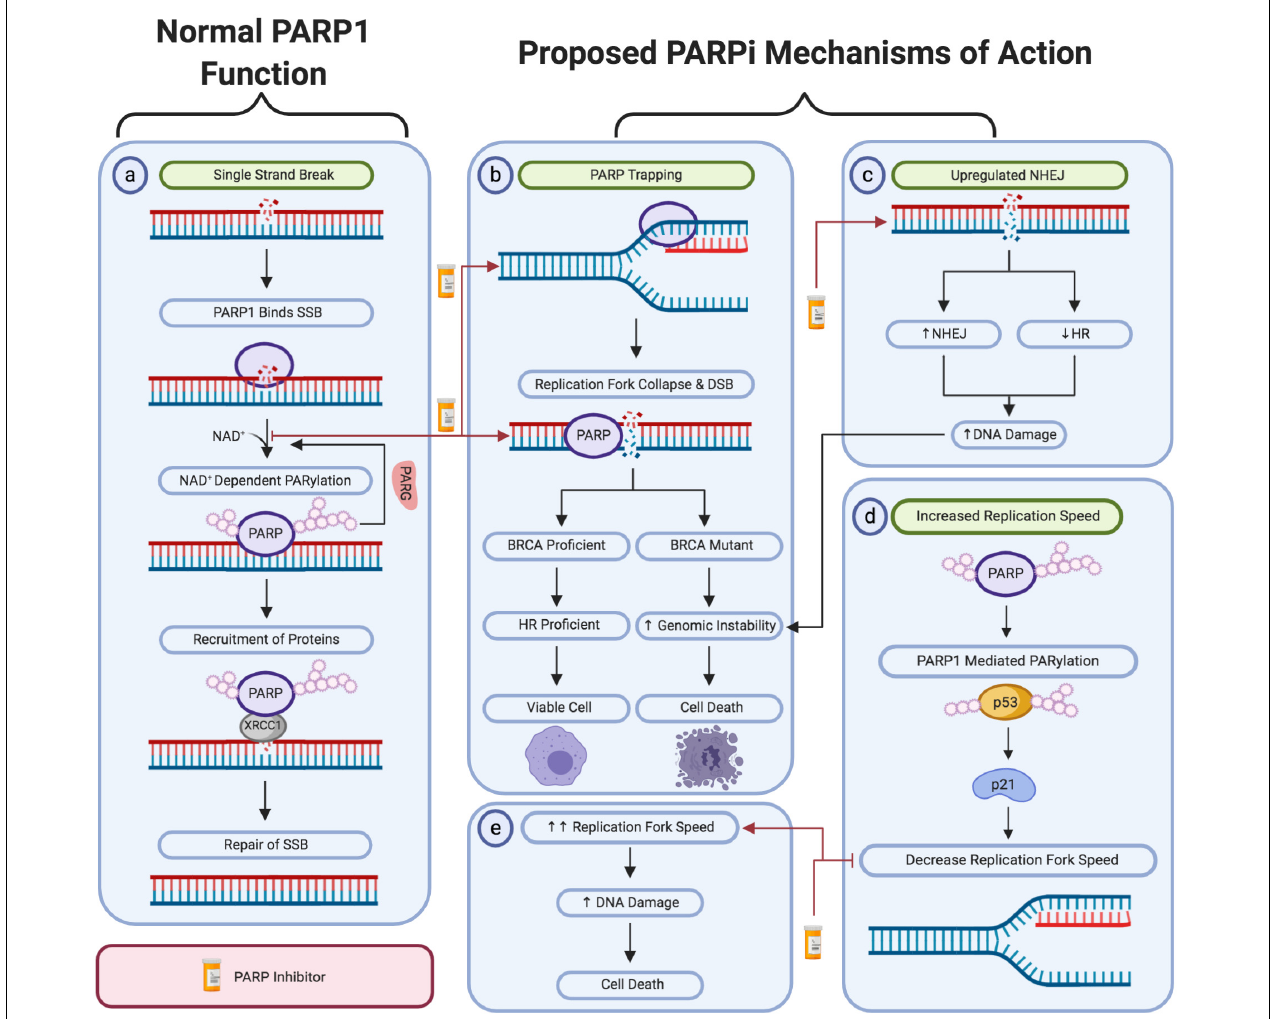
FIGURE 1 | A schematic representation of PARP1 activity in single-strand break repair and the proposed mechanism of action of PARP inhibitors. (a) The activity of PARP1 in the repair of oxidative stress-induced single-strand breaks via the base excision repair pathway. The proposed PARPi-induced: (b) PARP trapping mechanism. (c) Upregulation of non-homologous end joining activity and downregulation of homologous recombination repair. (d,e) Loss of negative regulation of replication fork speed. Created with